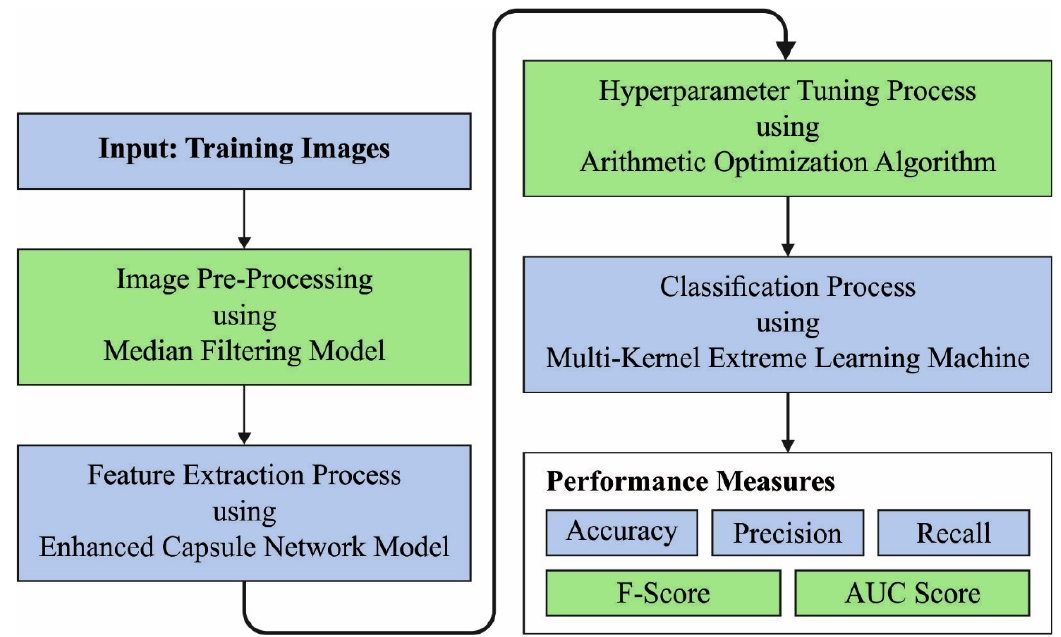
Figure 1. Working Process of ARAC ‐ AOADL technique.